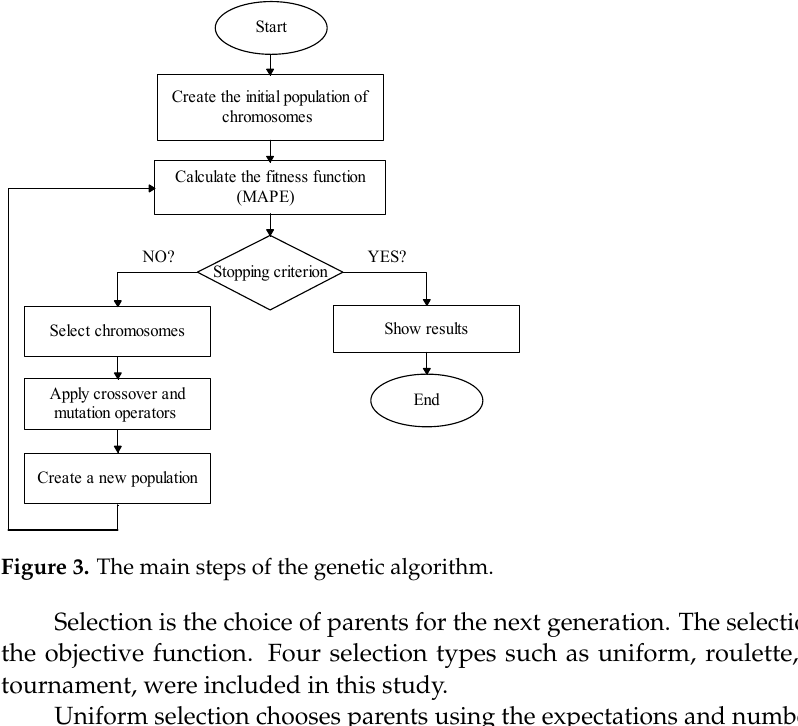
5 of 12 Table 3. Ranges of process parameters. #